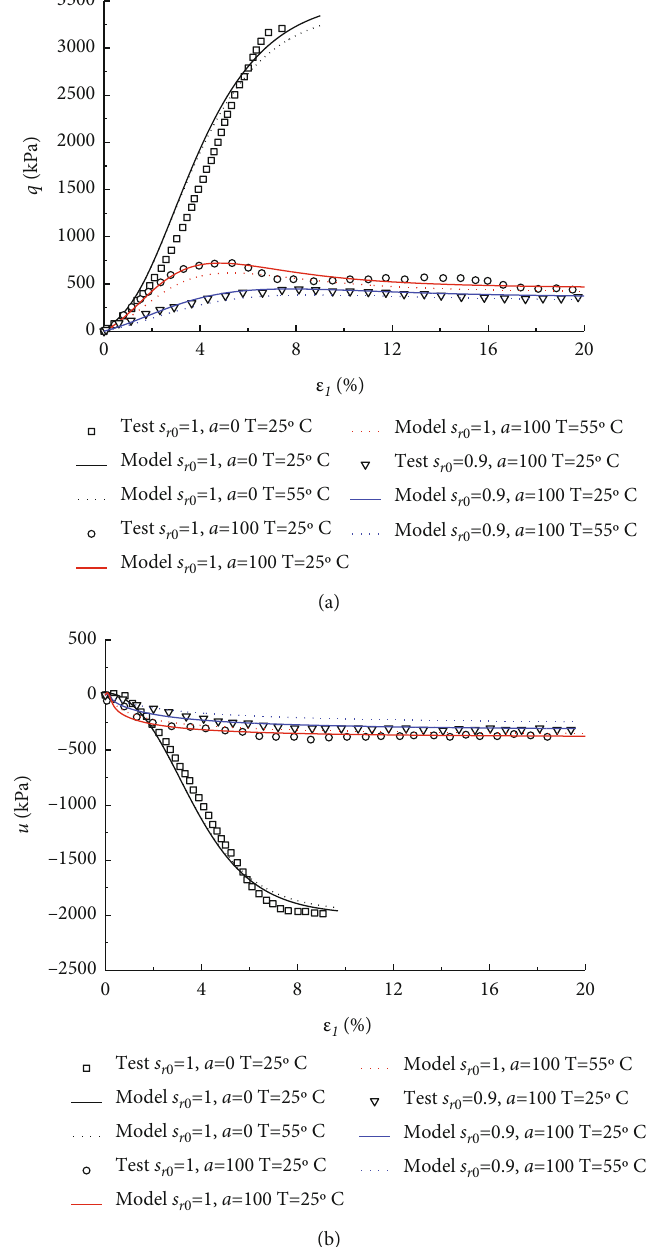
Figure 7: Simulation of undrained shear properties of dense gassy sand with di ff erent initial saturation at di ff erent temperatures: (a) stress- strain relationships; (b) excess pore water pressure (test data after Rad et al.